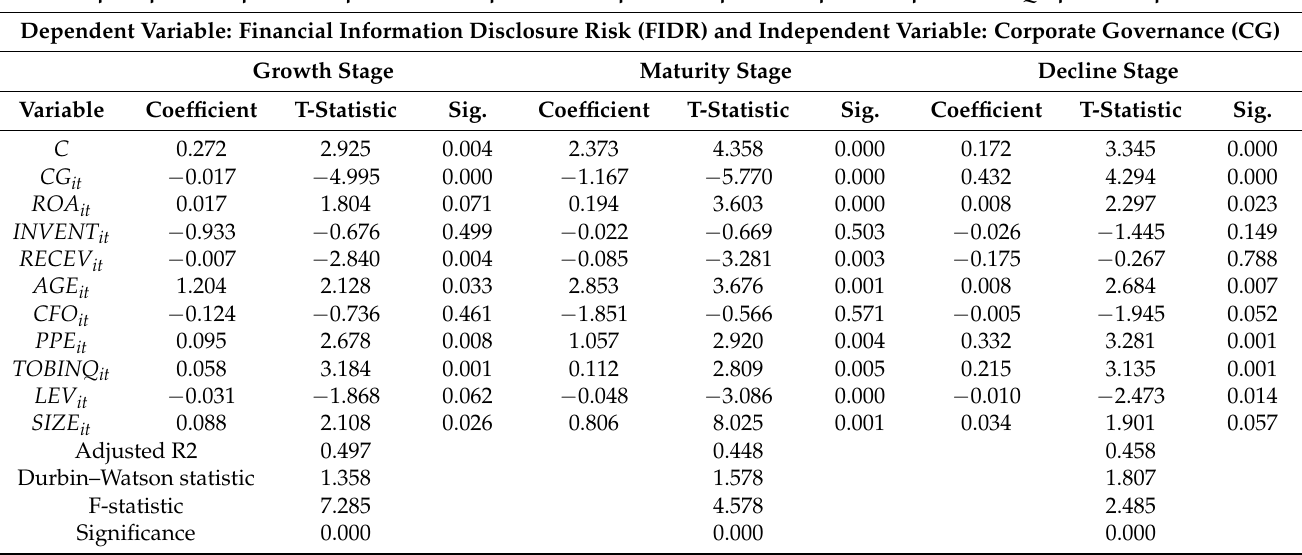
Table 12. The results of the statistical test of the second hypothesis in the life cycle stages.